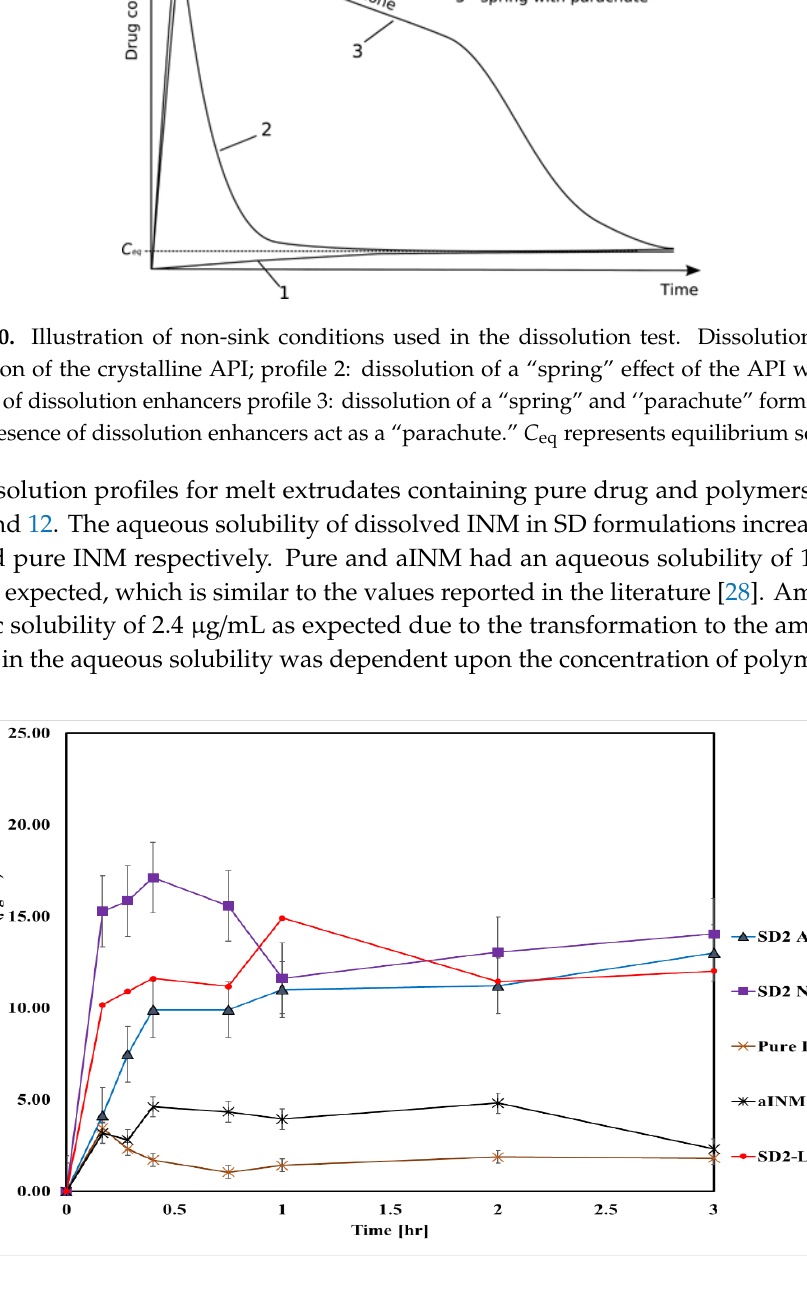
Figure 11. In-vitro dissolution profiles of air-cooled SD formulations performed in buffer of pH 1.2.